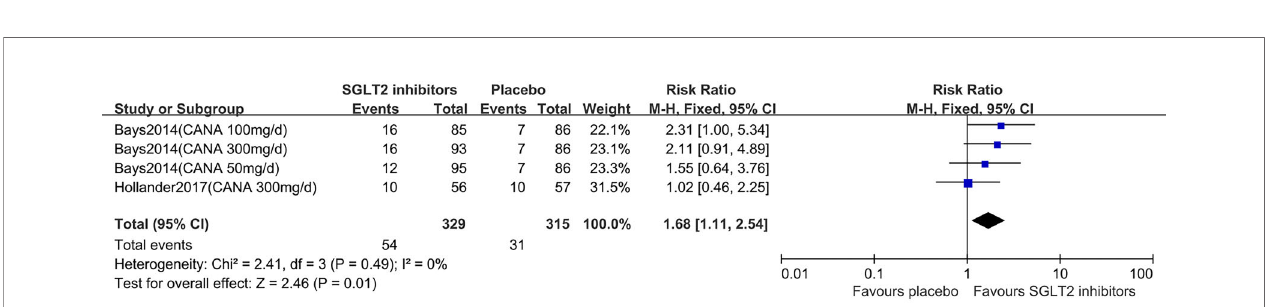
FIGURE 5 | Changes of weight loss ≥ 5% in patients receiving SGLT2 inhibitors versus placebo. CI, con fi dence interval; M-H, Mantel-Haenszel.